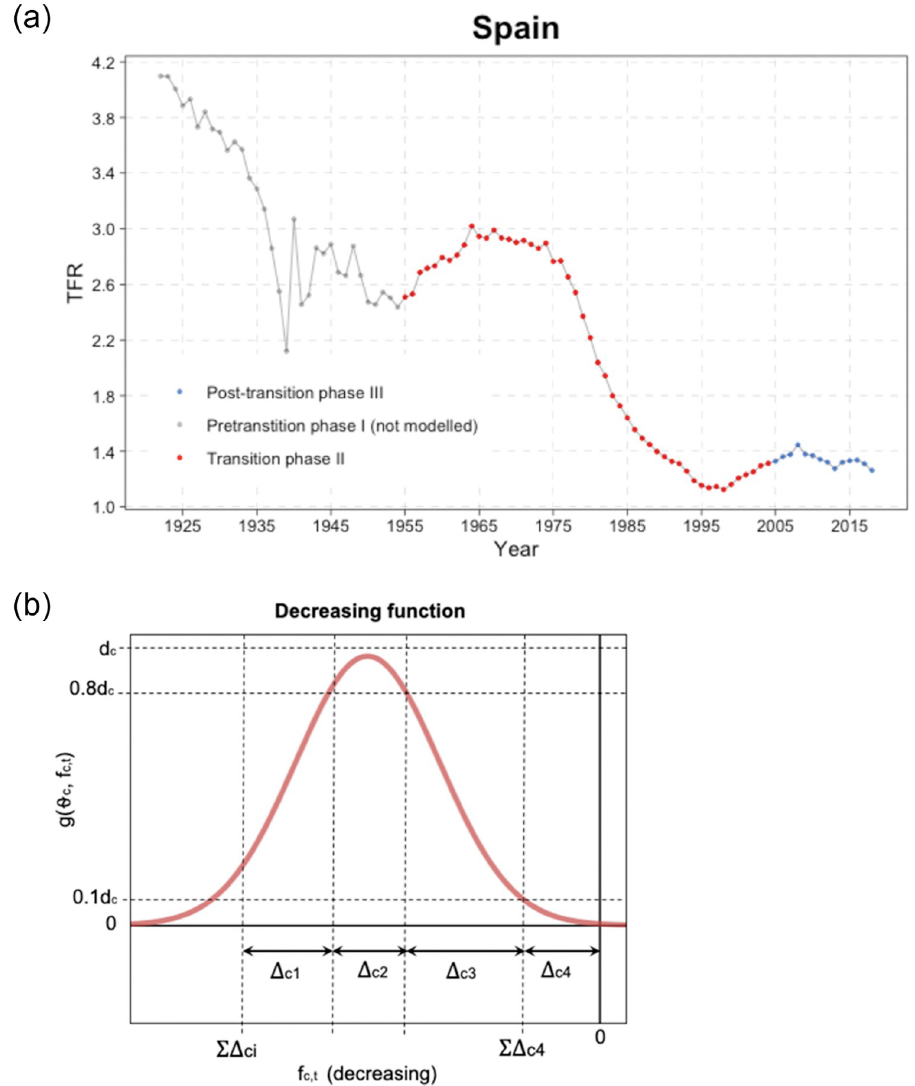
Fig 5. Phases of the TFR evolution. Three phases of the typical TFR evolution for the example of Spain (left); chart of a double logistic decline curve (right). The right figure shows a double logistic decline curve for Spain with its parameters defining the shape f on the x axis denotes the TFR, while g ( θ c , t difference in TFR. Source: Own elaboration.